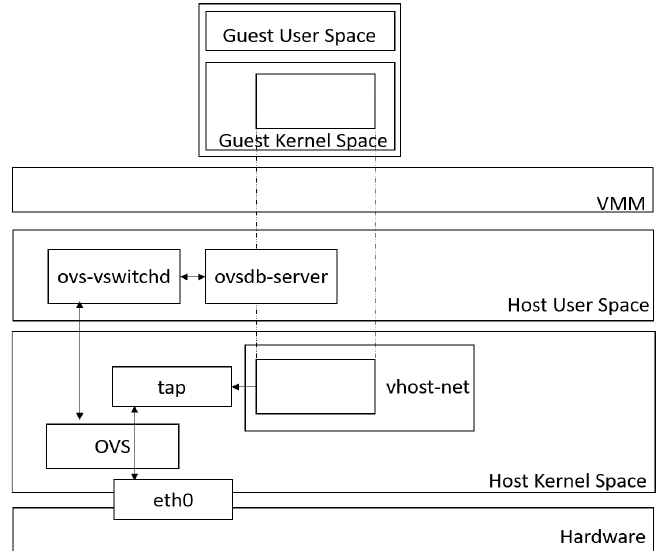
Figure 2. OVS architecture.